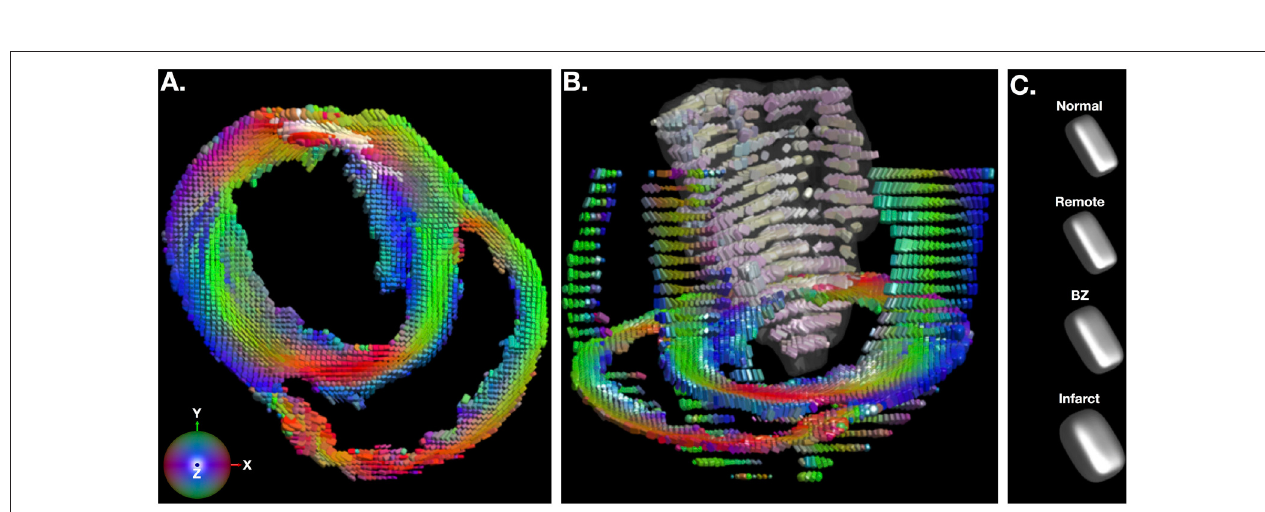
FIGURE 3 | (A) Short-axis depiction of diffusion tensor shape and orientation rendered with superquadric glyphs. The long-axis of each glyph is aligned with the primary eigenvector of the diffusion tensor at each voxel. Glyphs are color coded by the primary eigenvector direction with red grossly aligning with the left-right direction, green with the up-down direction, and blue with the through plane direction. The brightness of glyphs in the infarct is enhanced for contrast. (B) Short-axis, long-axis and whole-infarct depiction of diffusion tensor shape and orientation rendered with superquadric glyphs. (C) Superquadric glyphs of the diffusion tensor shape from normal hearts and remote, borderzone (BZ) and infarcted regions of the heart using the median values of ADC, FA, and tissue mode from Table 1 . Supplementary Movie 1 is available in the Supplementary Material.